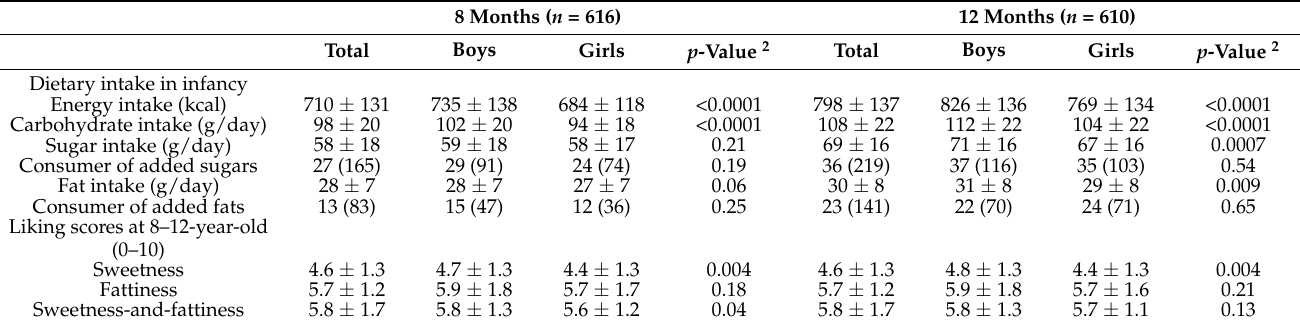
Table 2. Dietary intakes in infancy and the liking scores in young children according to child’s sex 1